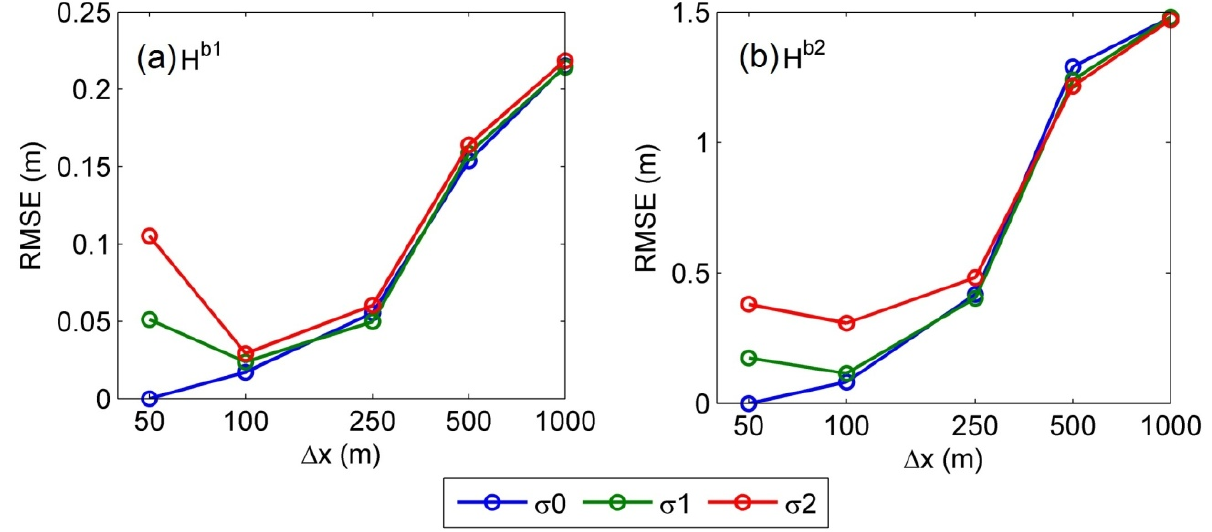
Figure 5. The trade-off analysis of grid-box size ( ∆ x) and DEM error ( σ ) on water elevation RMSE at locations ( a ) b1 and ( b ) b2 in Figure 3,